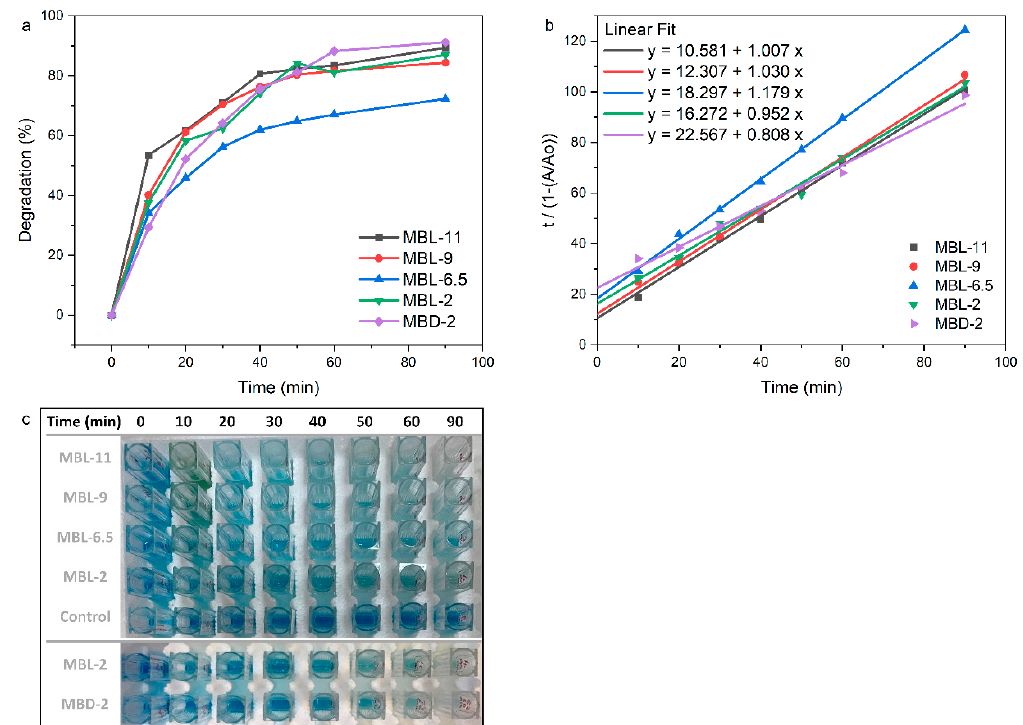
Figure 4 . ( a ) The percentage of the MB dye degradation, ( b ) the linear fitting of the MB experimental data with the BMG kinetic model and ( c ) photographs of the degraded MB dye during 90 min by the same catalyst in different pH values under the sunlight and the darkness.